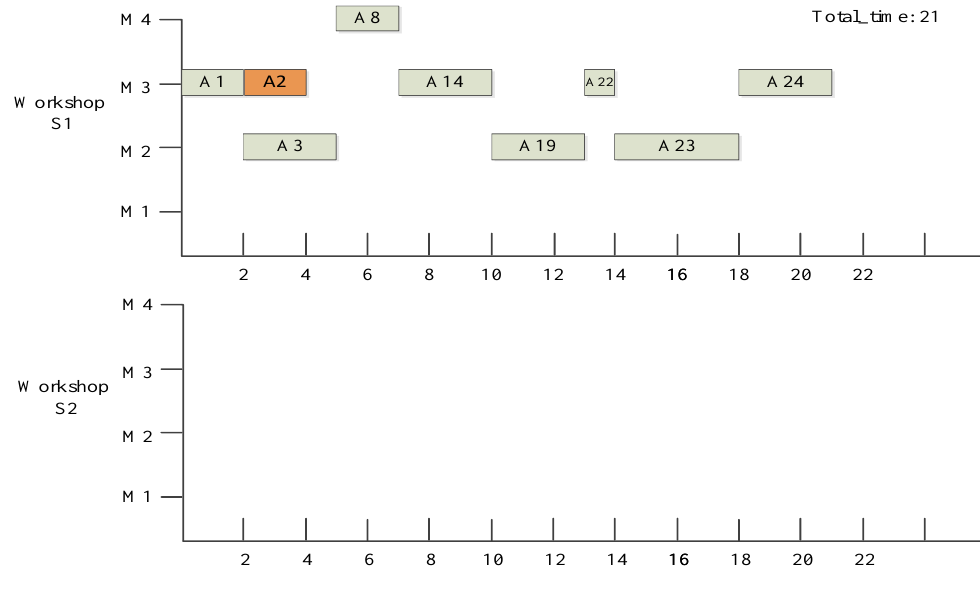
Figure 4. The process A2 scheduling scheme.